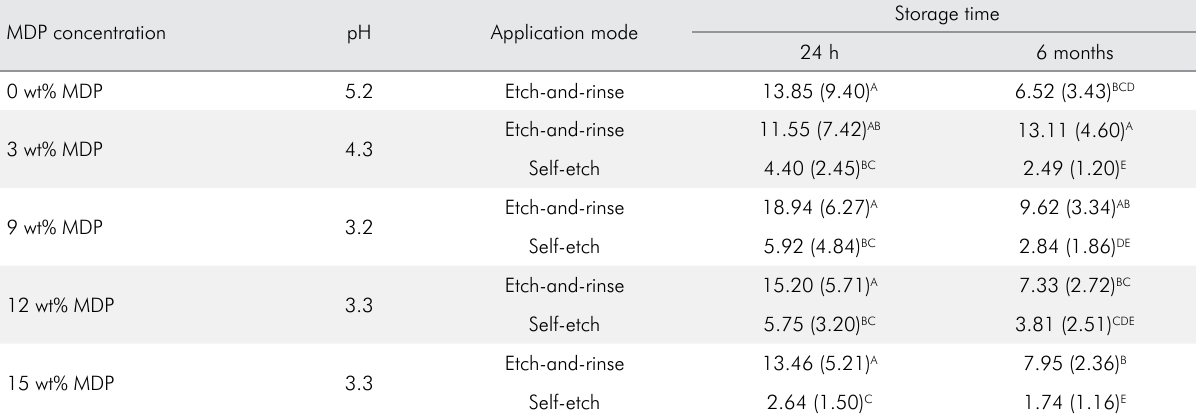
Table 2. Mean values and standard deviations for the bond strength values according to MDP concentration, application mode and storage